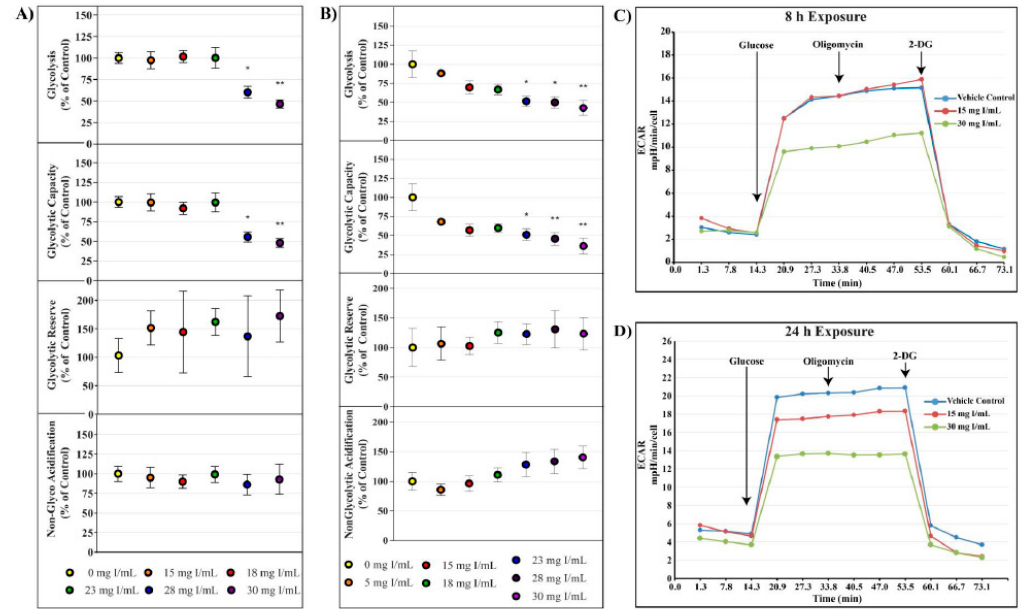
Figure 4. Diatrizoic acid effects on various parameters of glycolysis in HK-2 cells. DA diminished key parameters of glycolysis following 8 h ( A ) and 24 h ( B ) exposure. Representative time course profile of extracellular acidification rate (ECAR) of a Seahorse cell glycolytic stress test following exposure to DA for 8 h ( C ) and 24 h ( D ). Statistical difference from 0 mg I/mL DA depicted by an asterisk (* p < 0.05, ** p < 0.01). Values represent mean ± SEM for three independent experiments.